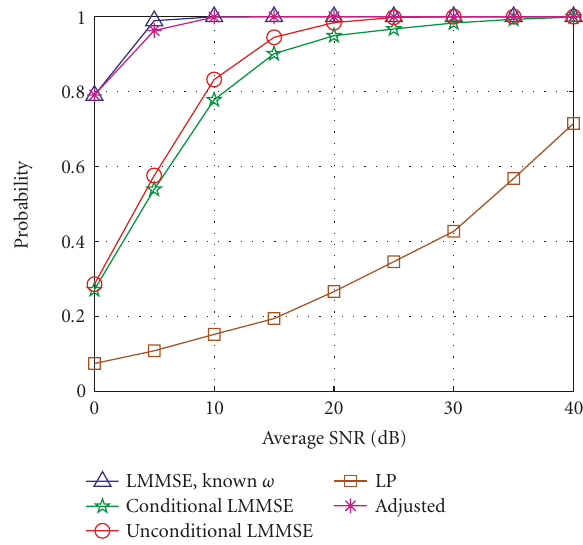
Figure 8: Performance evaluation of LMMSE prediction methods in an urban